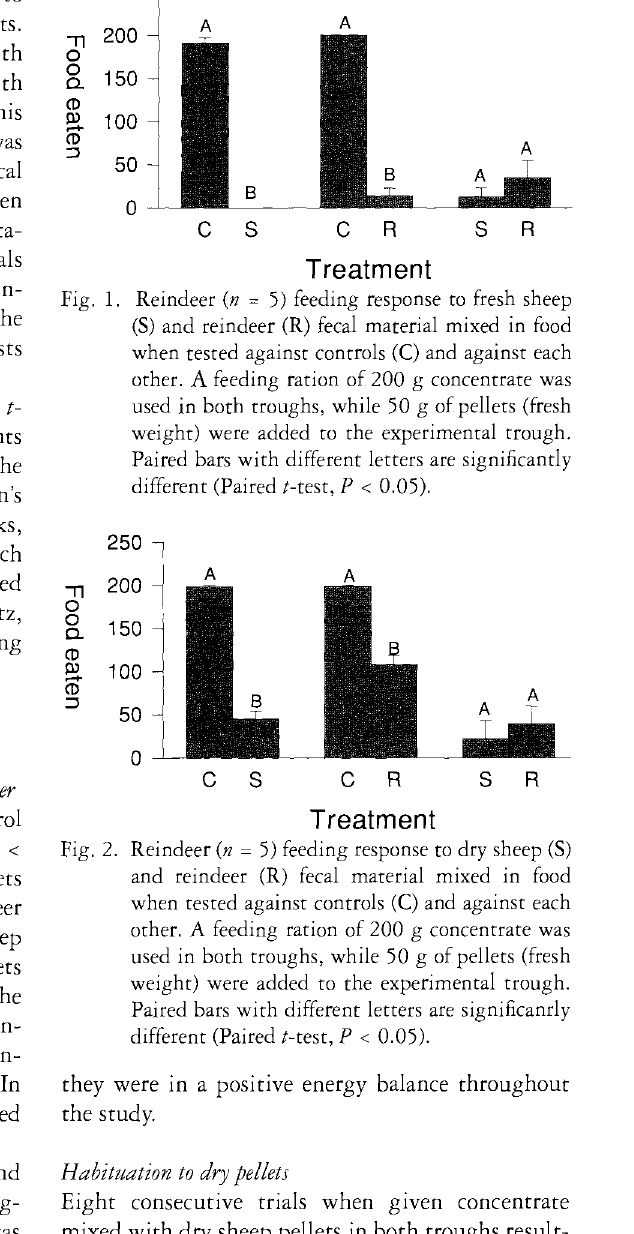
Fig. 1. Reindeer (n = 5) feeding response to fresh sheep (S) and reindeer (R) fecal material mixed in food when tested against controls (C) and against each other. A feeding ration of 200 g concentrate was used in both troughs, while 50 g of pellets (fresh weight) were added to the experimental trough.